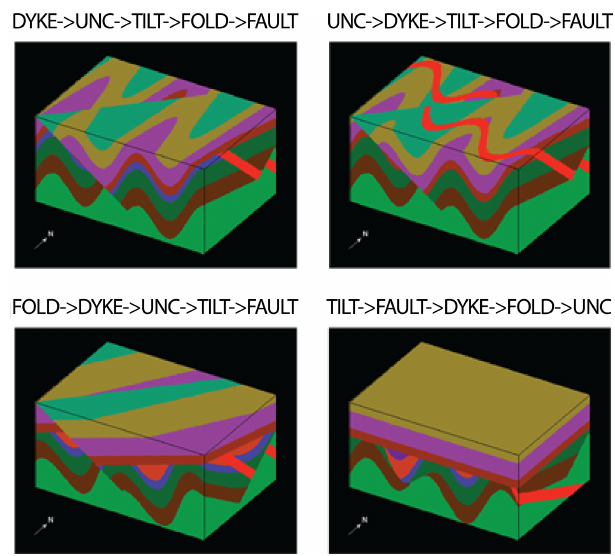
Figure 3. Four possible 3D geological models with the same base stratigraphy (STRAT) followed by five events using four of the pos- sible different event ordering